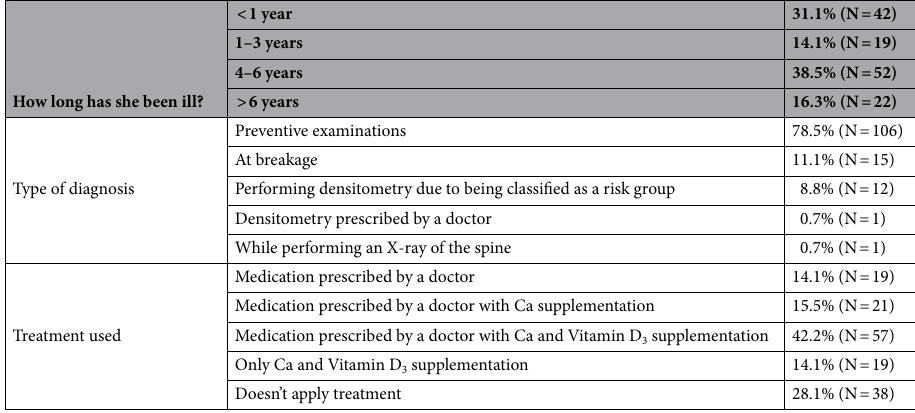
Table 4. Basic information about osteoporosis among the surveyed